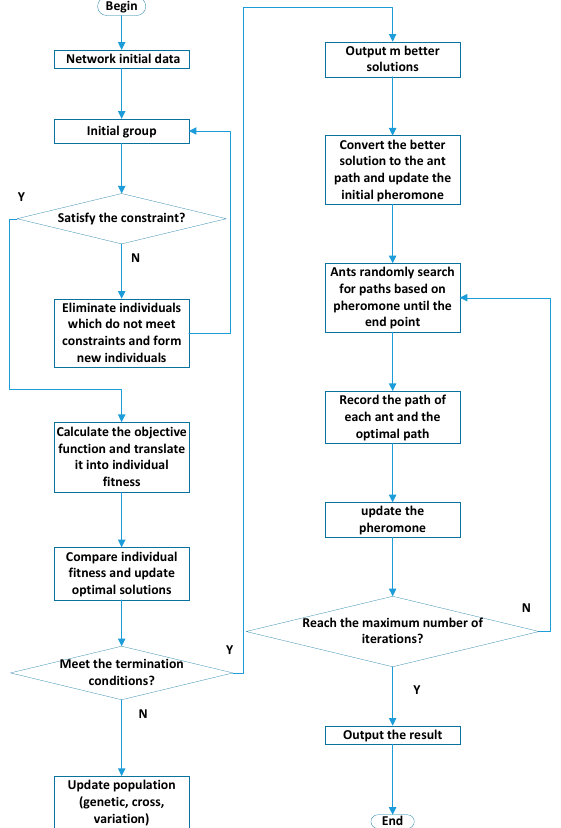
Figure 6. Algorithm flow chart.